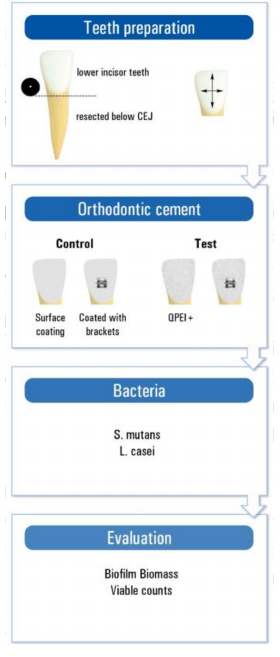
Figure 1. Schematic presentation of the experimental